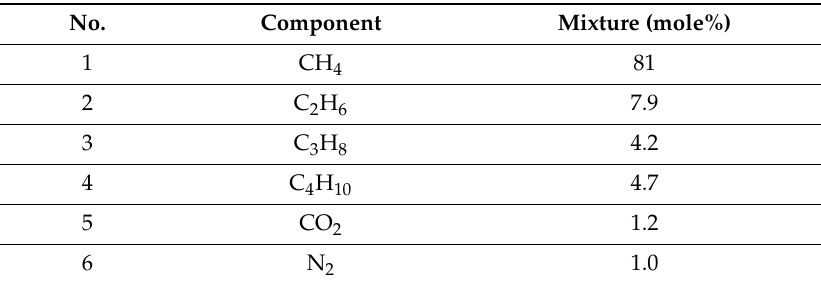
Table 1. The natural gas molar composition [31].